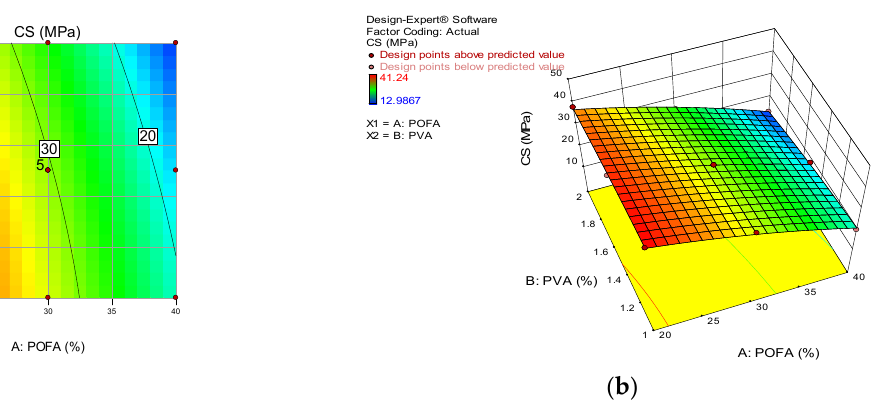
Figure 20. ( a ) 2D Contour Plot and ( b ) 3D Response Surface Diagram for Compressive Strength.